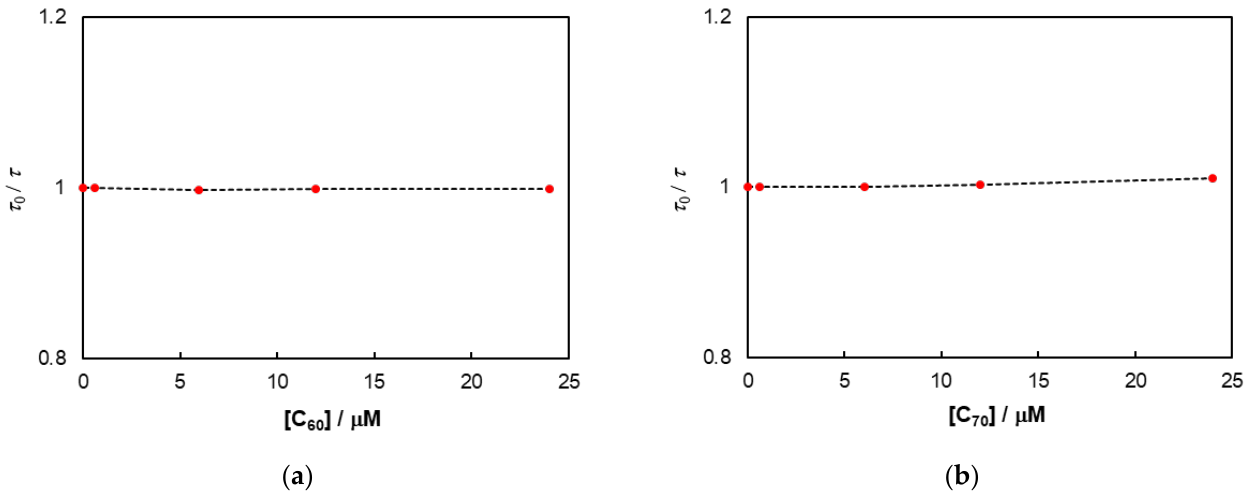
Figure 5. Lifetimes of 4 in toluene solution (6.0 × 10 −7 M) upon addition (6.24 × 10 −7 − 2.40 × 10 −5 M) of fullerene C 60 ( a ) and C 70 ( b ) ( λ exc = 340 nm).